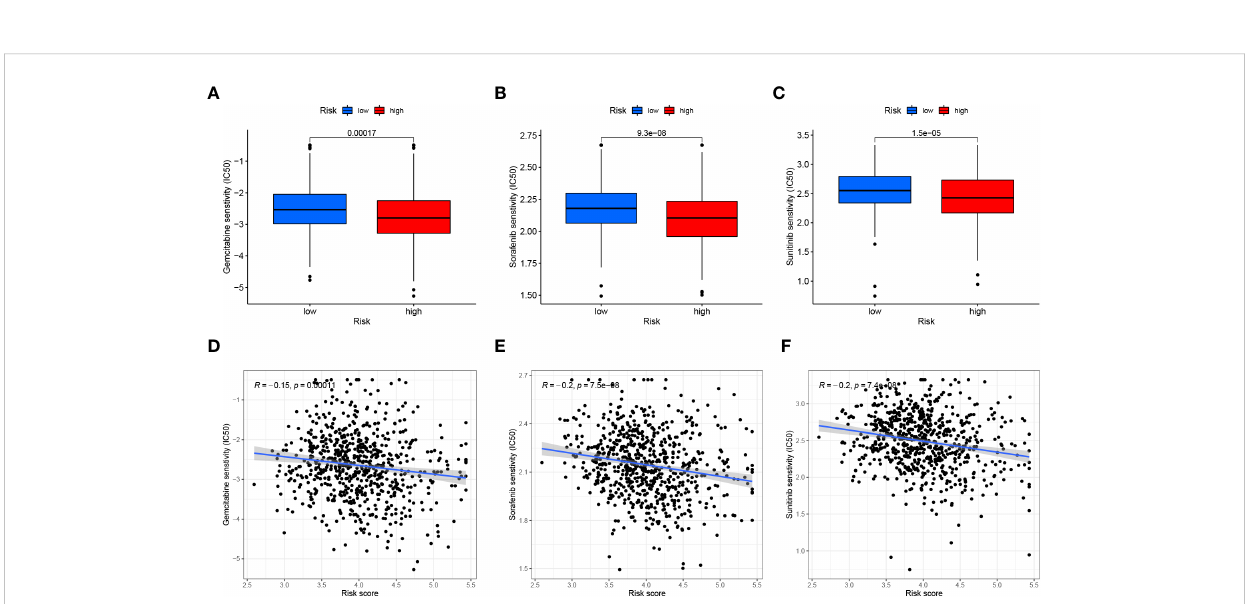
FIGURE 14 Drug sensitivity analysis. (A – C) Comparison of the Gemcitabine, Sorafenib and Sunitinib (IC50) between the two groups. (D – F) The relationship between risk score and Gemcitabine, Sorafenib and Sunitinib (IC50) sensitivity.